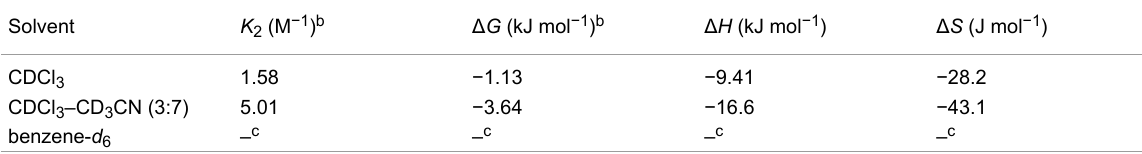
Table 2: Association (dimerization) constants and thermodynamic parameters of 23 in various solvents a . Solvent